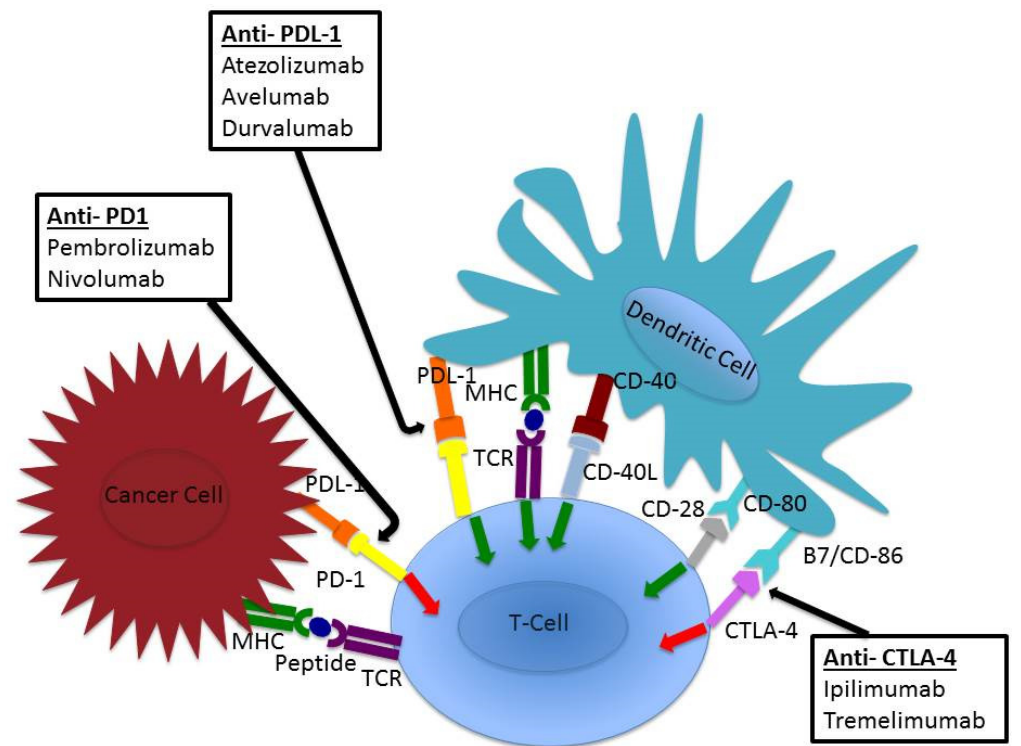
Figure 1. Immune checkpoints receptors and ligands on T cell, dendritic cell and tumour cell surfaces. T cell inhibitory signalling demonstrated with red arrows, stimulatory signalling demonstrated with green arrows. Site of action for developed Anti-PD-1, Anit-PD-L1 and Anti-CTLA-4 antibodies shown with black arrows.